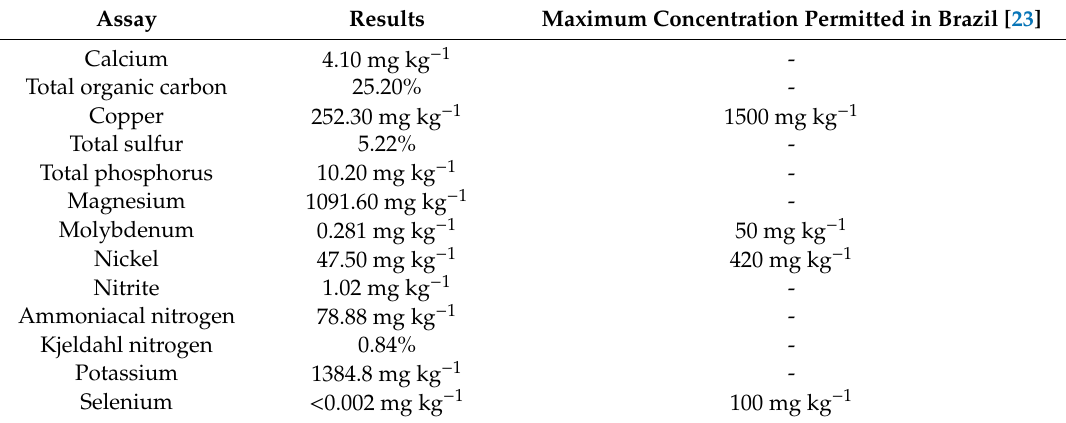
Table 6. Classification of macro- and micronutrients of e ffl uent treatment station (ETS) primary sewage sludge: method of analysis, according to the Standard Methods for Examination of Water and Wastewater, 20th ed. [9] and maximum permitted concentration in Brazil [23]. Assay